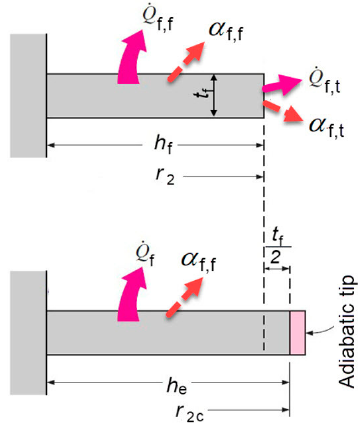
Figure 3. Adiabatic fin tip assumption.